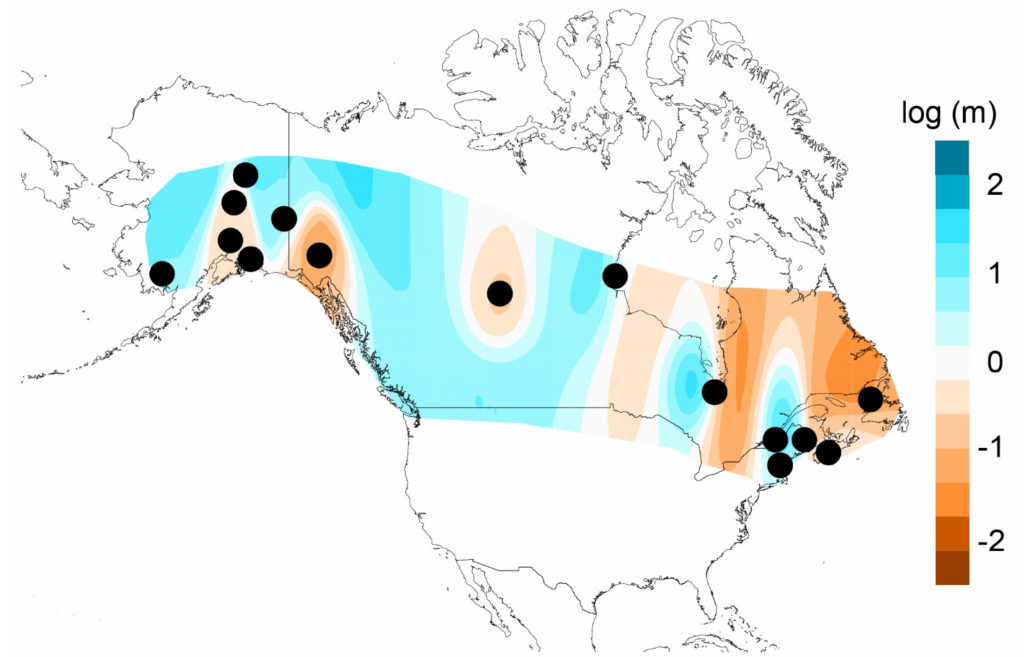
Figure 5. The estimated effective migration surfaces between all sampling locales (black circles) for deme size 250. White areas indicate gene flow rates consistent with isolation by distance expectations whereas shaded areas have dispersal rates that are higher (blue, corridors) or lower (orange, barriers) than expected under isolation-by-distance (IBD). We note that orange area around the Yukon Territory sampling location showed opposite pattern when deme size was lower than 250 (higher than average gene flow rate). For all other areas deme size did not change results.